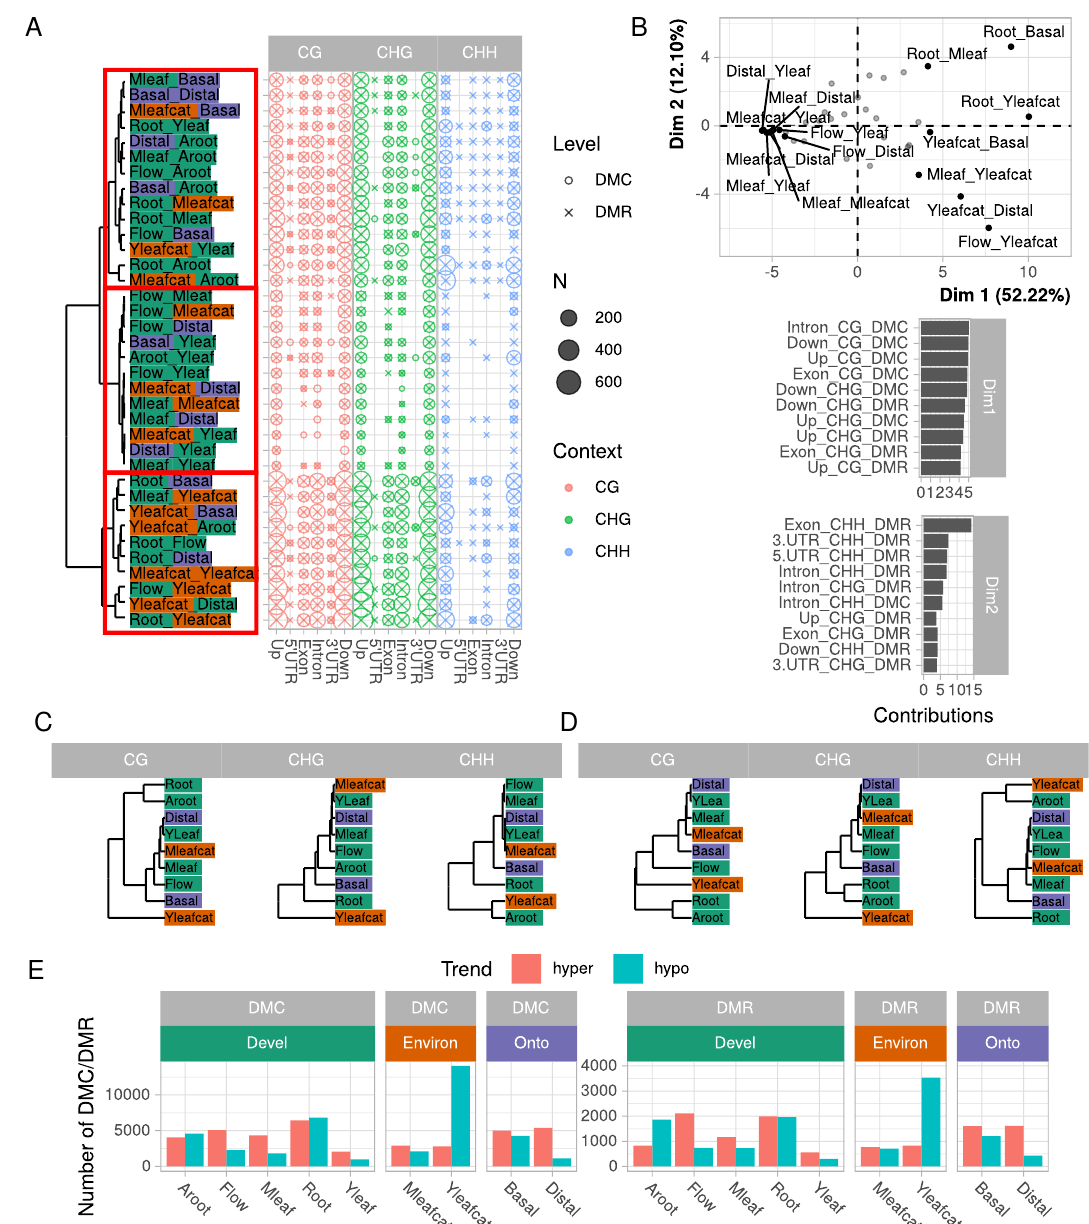
Figure 2. Classification of samples according to DMC and DMR numbers and contexts . ( A ) number of DMC and DMR in all 36 pairwise comparisons, for each context and gene model feature. Comparisons were clustered using an Euclidean distance calculated on the number of DMCs/DMRs and the Ward agglomeration criterion. ( B ) principal component analysis of DMC/DMR number. Comparisons are projected on the two first dimensions but names are indicated only for the 15 highest contributions. For both dimensions, the five highest variable contributions are represented below. ( C , D ) samples clustered according to the numbers of DMC and DMR, respectively. Euclidean distances were calculated on square matrices containing samples in rows and columns. Clustering was constructed according to Ward agglomeration criterion; ( E ) number of hyper- and hypo-methylated DMCs/DMRs for each sample compared with all eight